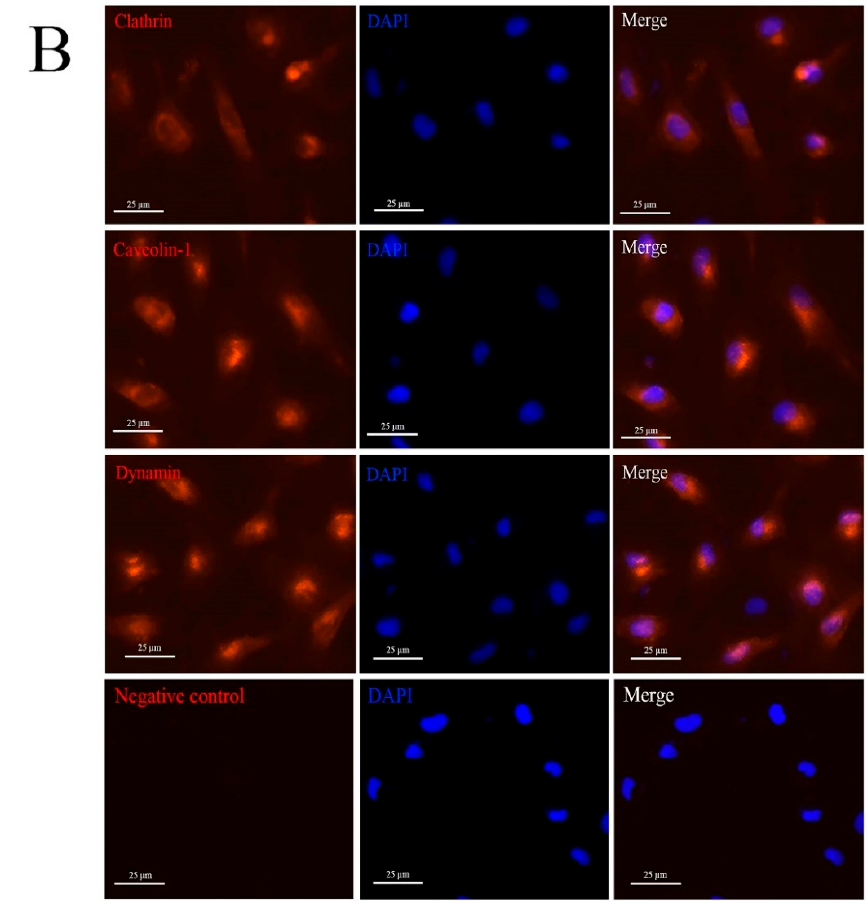
Figure 1. Specificity analysis of mouse anti-clathrin, anti-caveolin-1, and anti-dynamin polyclonal antibodies. ( A ) The titer of mouse anti-clathrin, anti-caveolin-1, and anti-dynamin polyclonal antibodies analyzed by ELISA; error bars represent standard deviations (SD, n = 3). ( B ) The indirect immunofluorescence assay (IFA) of mouse anti-clathrin, anti-caveolin-1, and anti-dynamin polyclonal antibodies with FG cells; bars = 25 μ m. Mouse pre-immune serum was used as a negative control.